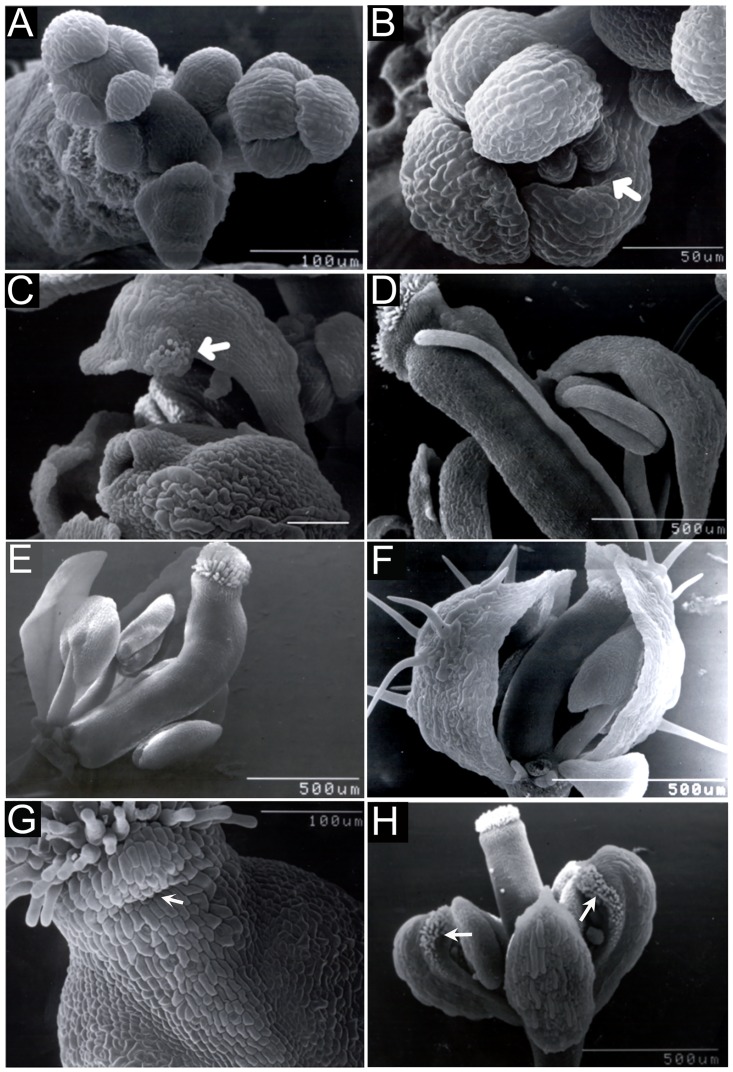
fil-10 conditions floral organ abnormalities. (A-G) fil-10 er flowers. (A) Early inflorescences showing symmetrically located sepal primordia. (B) An early bud with a gap (arrow) between two sepals. (C) A flower formed late in development with stigmatic tissue (arrow) on the tip of a sepal. (D) A flower with a third whorl filament lacking an anther. (E) A gynoecium with a bend. (F) A gynoecium in the midst of bending due to sustained contact with the inner face of a lateral sepal. (G) Medial region of a gynoecium showing a bulge of style tissue (arrow) under the stigma. (H) fil-10 ap1-1 er flower showing transformation of medial sepals (arrows) into carpelloid organs.